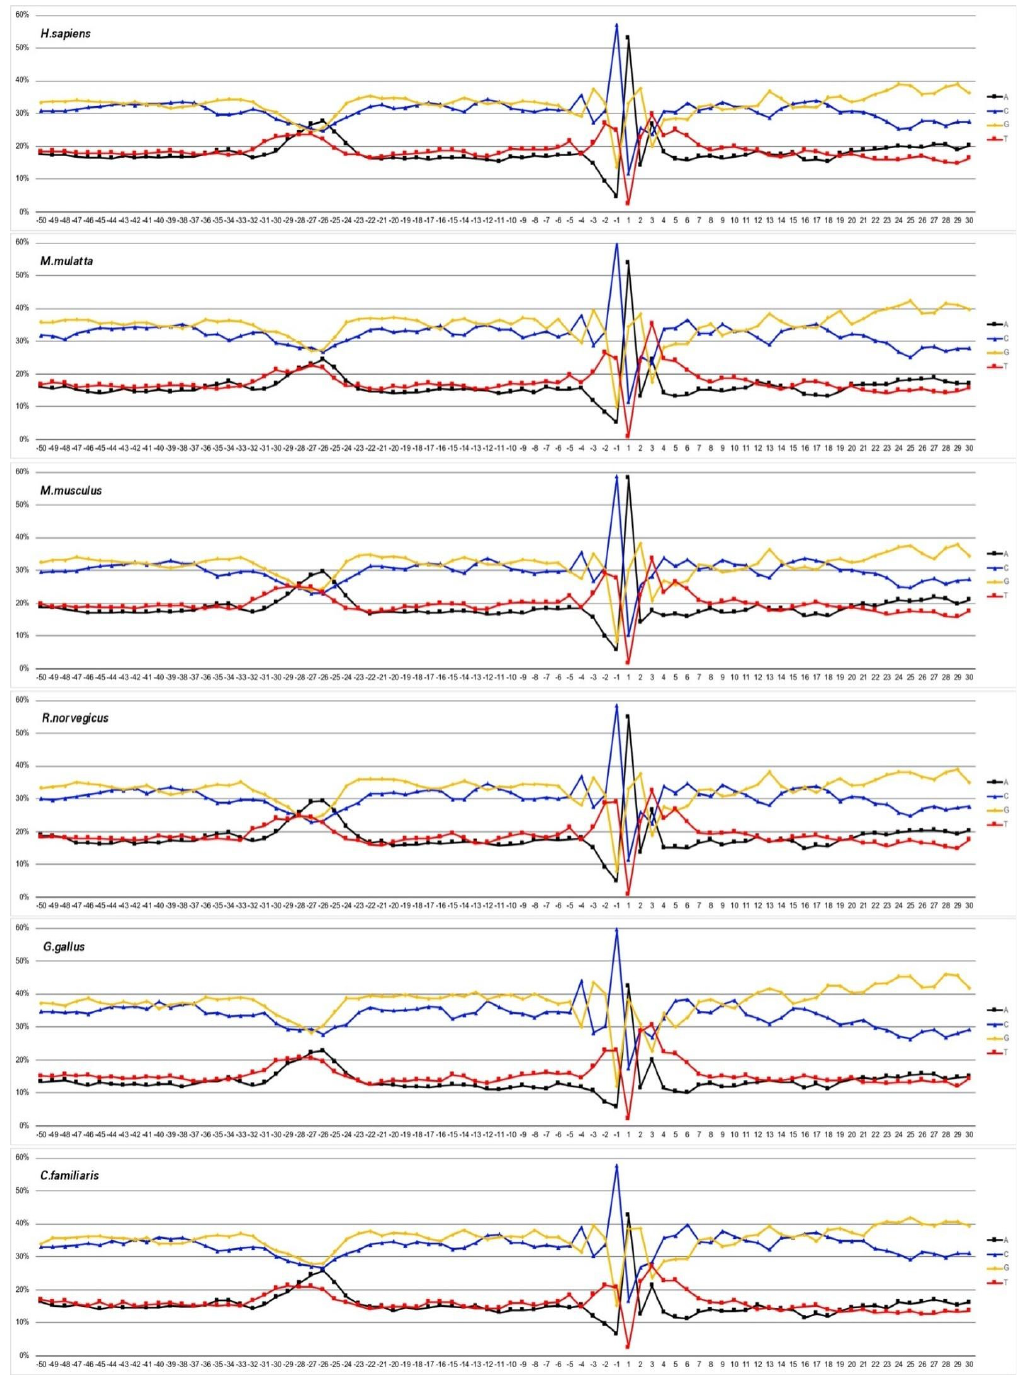
The logo-representation of the promoter sequences with an information content of 1.0 bits is shown in Figure 2, while that with an information content of 0.4 bits is shown in Figure S3. We present two options for scaling the logo image to best reveal the features of and C). Frequencies of mononucleotides occurrence at each position along the coding different fragments of core promoters because the frequencies of occurrence of nucleotides strand are shown in Figure 1A–D. differ sharply in different regions. Logos were made at http://weblogo.threeplusone.com (accessed on 24 July 2022).